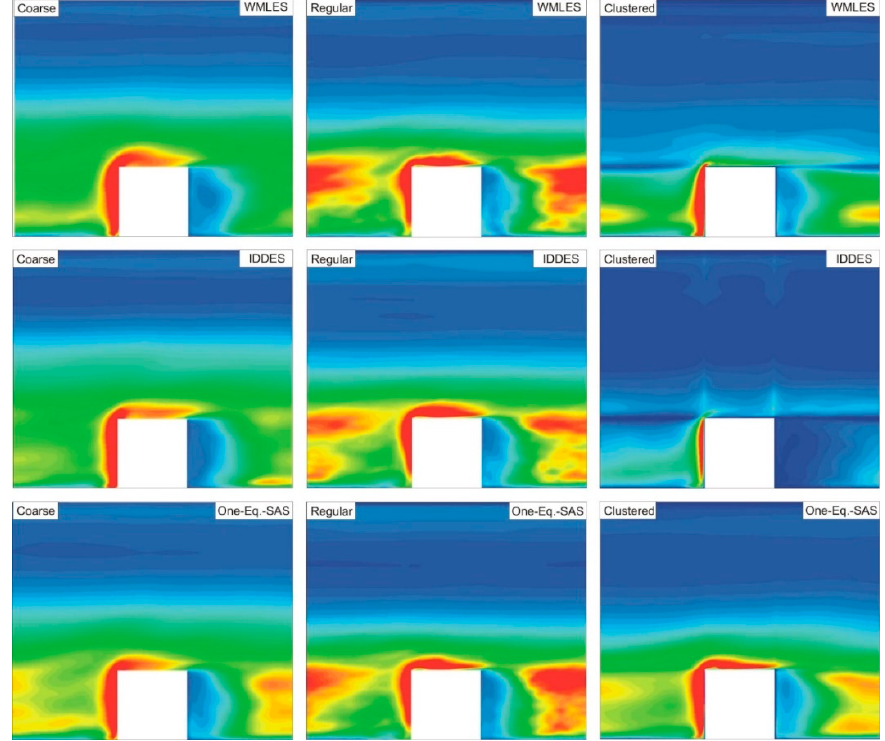
′ ′ 2 in the XY plane cutting through the w w /U in the XY plane cutting through the b b